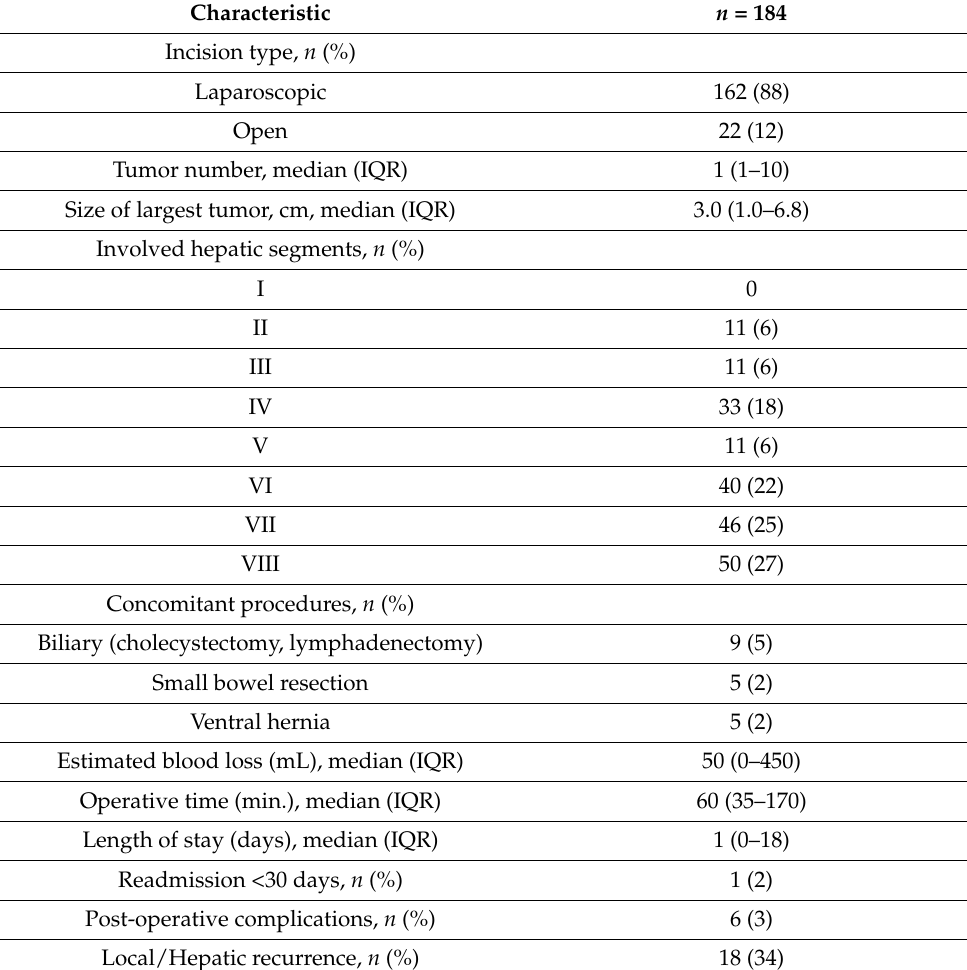
Table 2. Operative and outcome details of the study